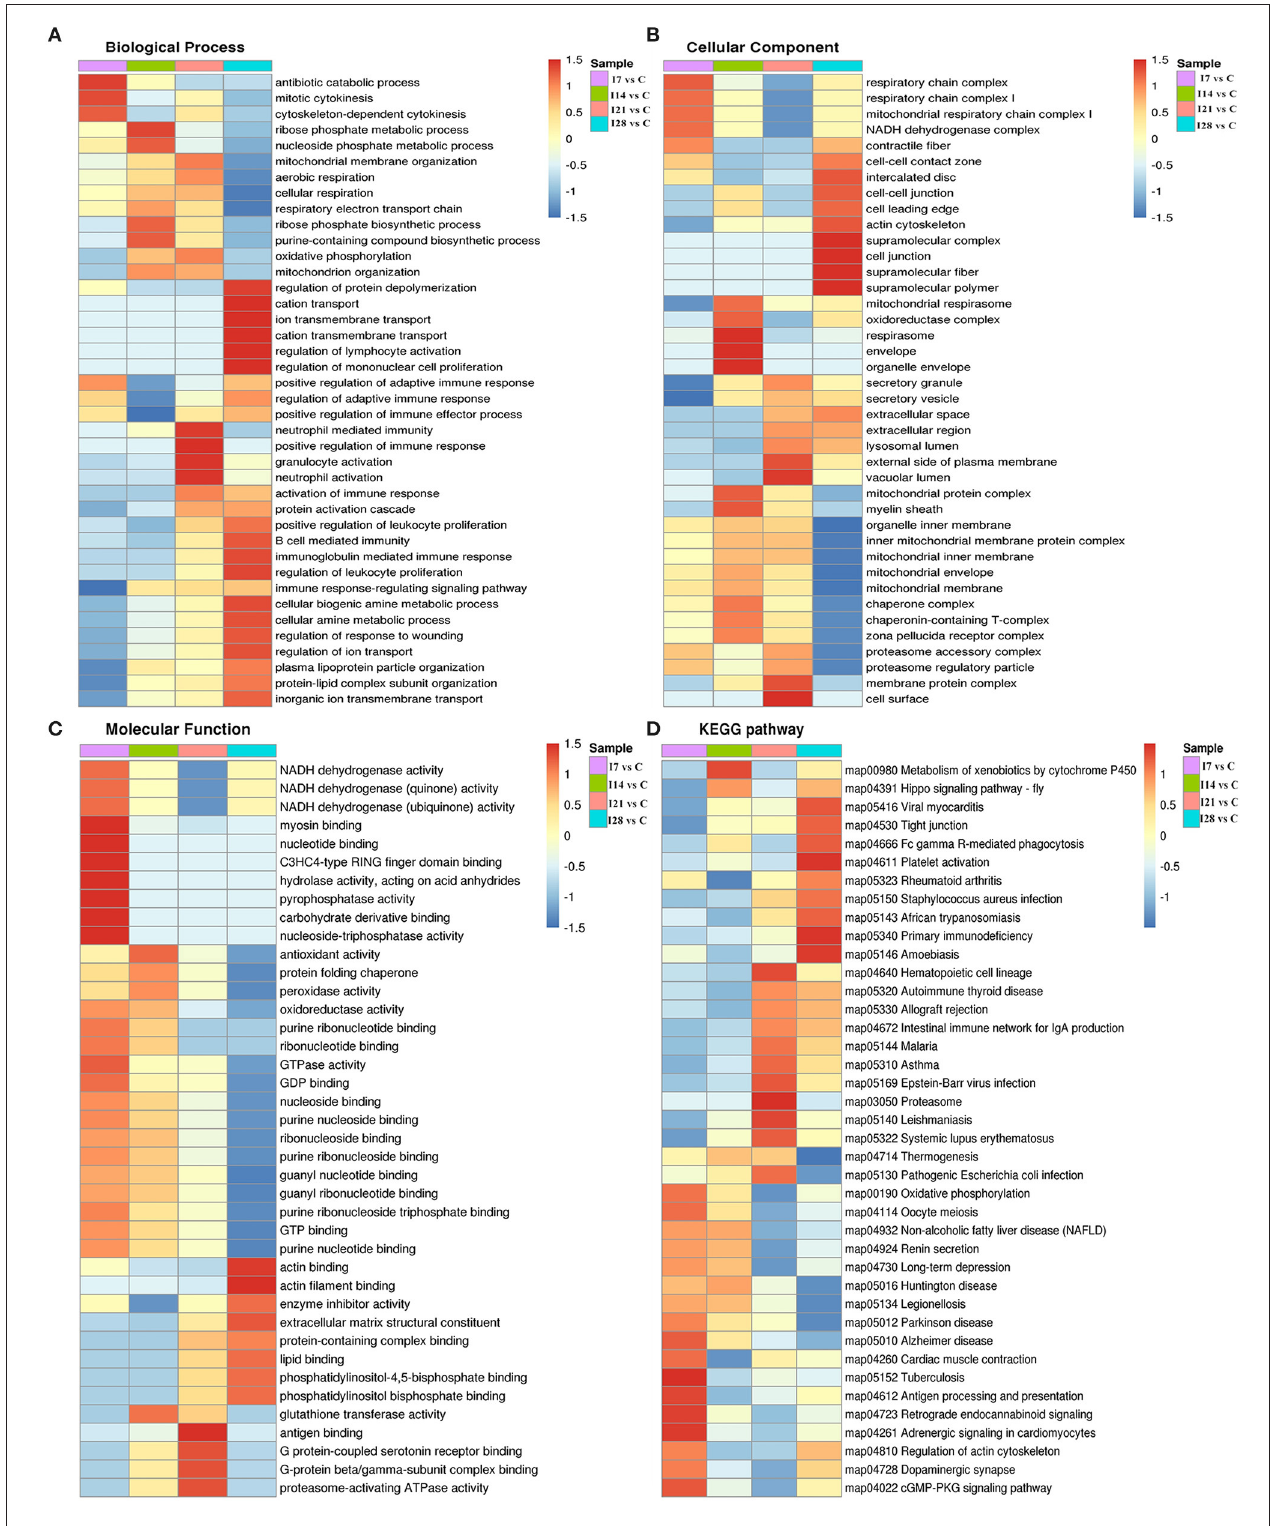
FIGURE 4 | Cluster analysis of differentially expressed proteins based on biological processes, cellular components, molecular functions, and Kyoto Encyclopedia of Genes and Genomes (KEGG) pathways. (A) Biological processes. (B) Cellular components. (C) Molecular functions. (D) KEGG pathways.